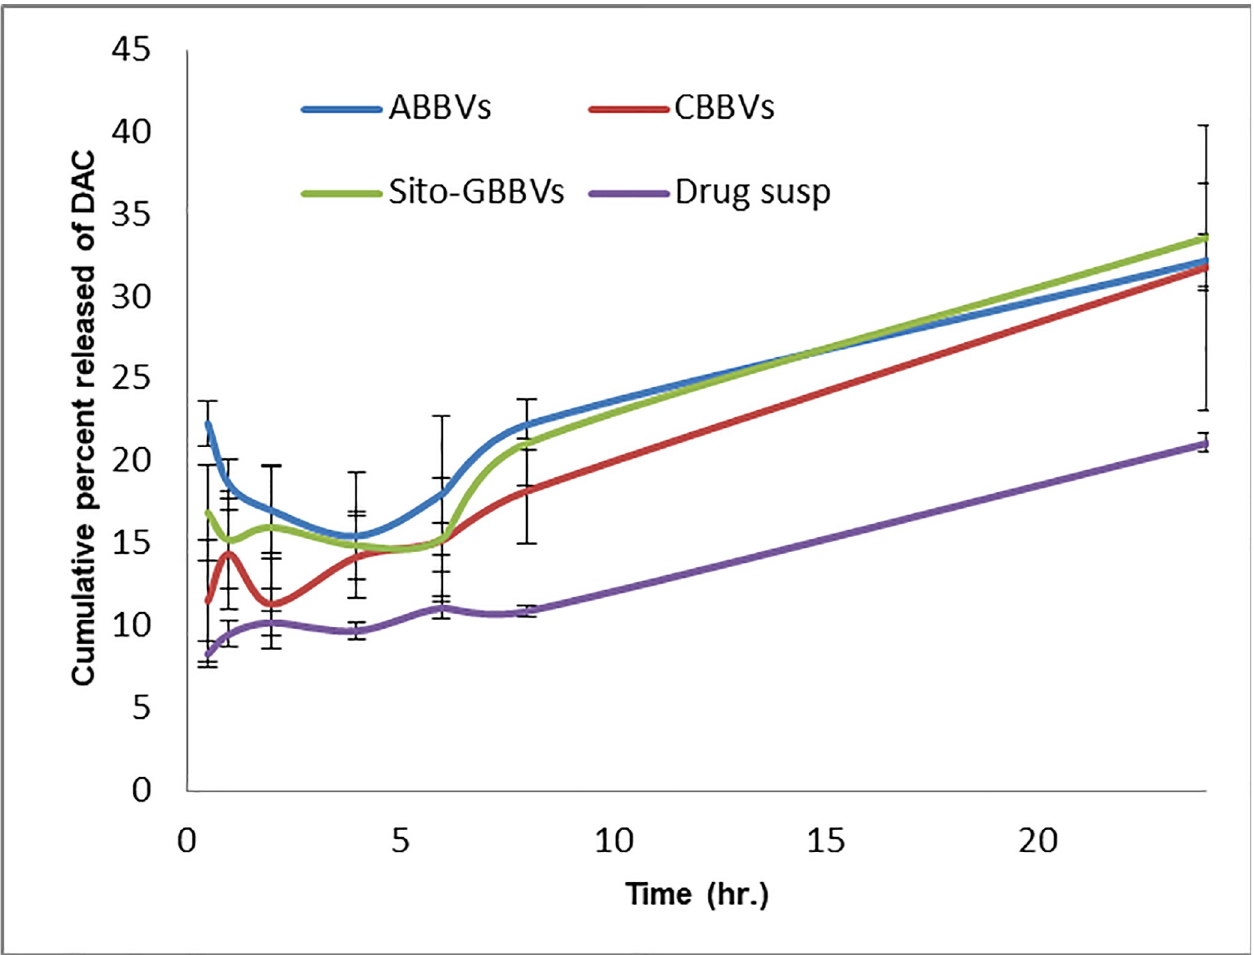
Fig 3. In-vitro release profiles of DAC from drug suspension, the ABBVs, CBBVs and Sito-GBBVs in phosphate buffer pH 6.8 with 0.75% Brij 35.